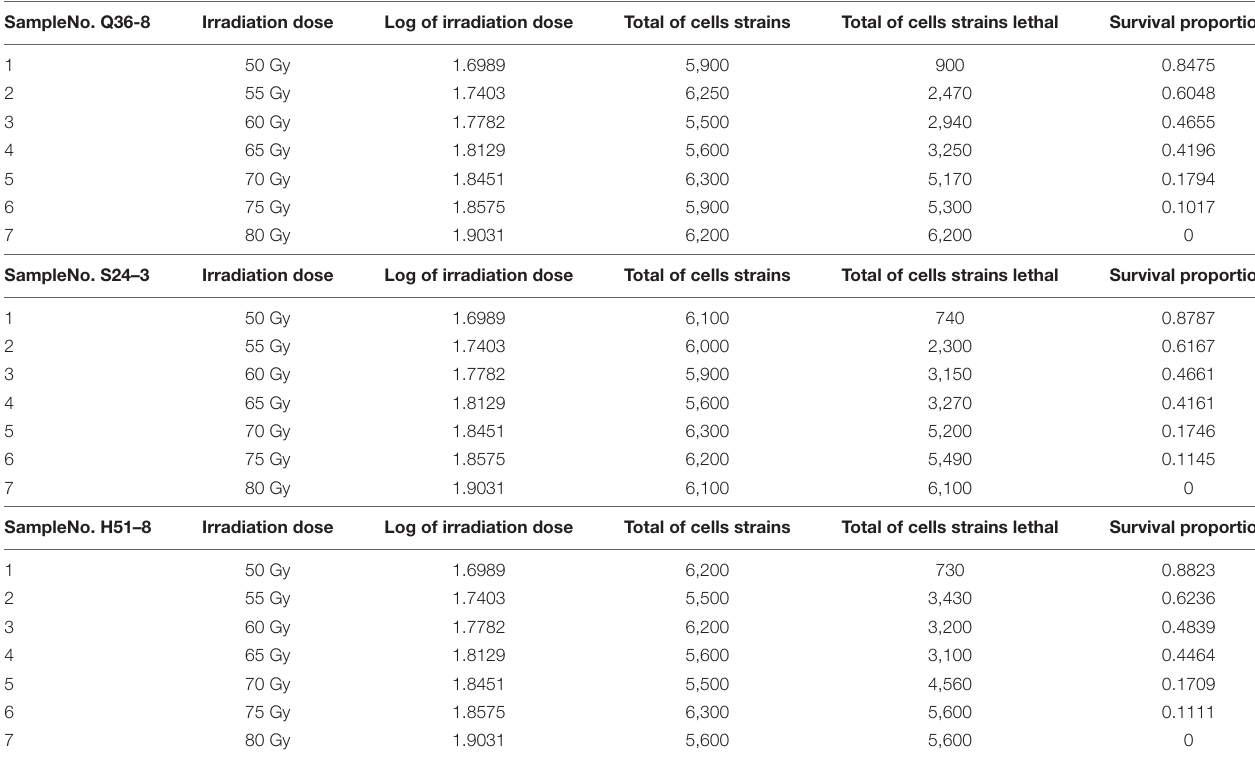
TABLE 2 | Random sampling locations after 12 C 6 + heavy-ion irradiation with an energy input of 220 AMeV and a dose of 50 ∼ 80 Gy. SampleNo. Q36-8